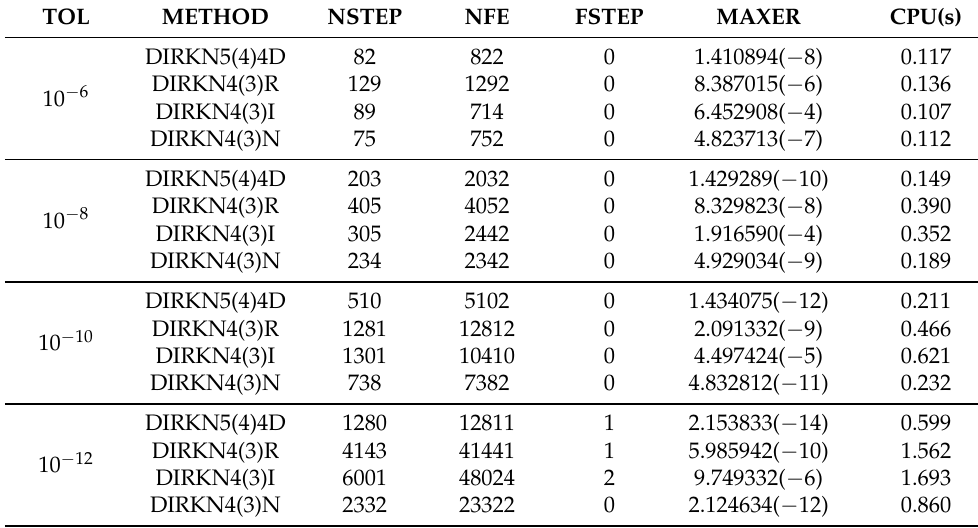
Table 3. Data for Example 2.